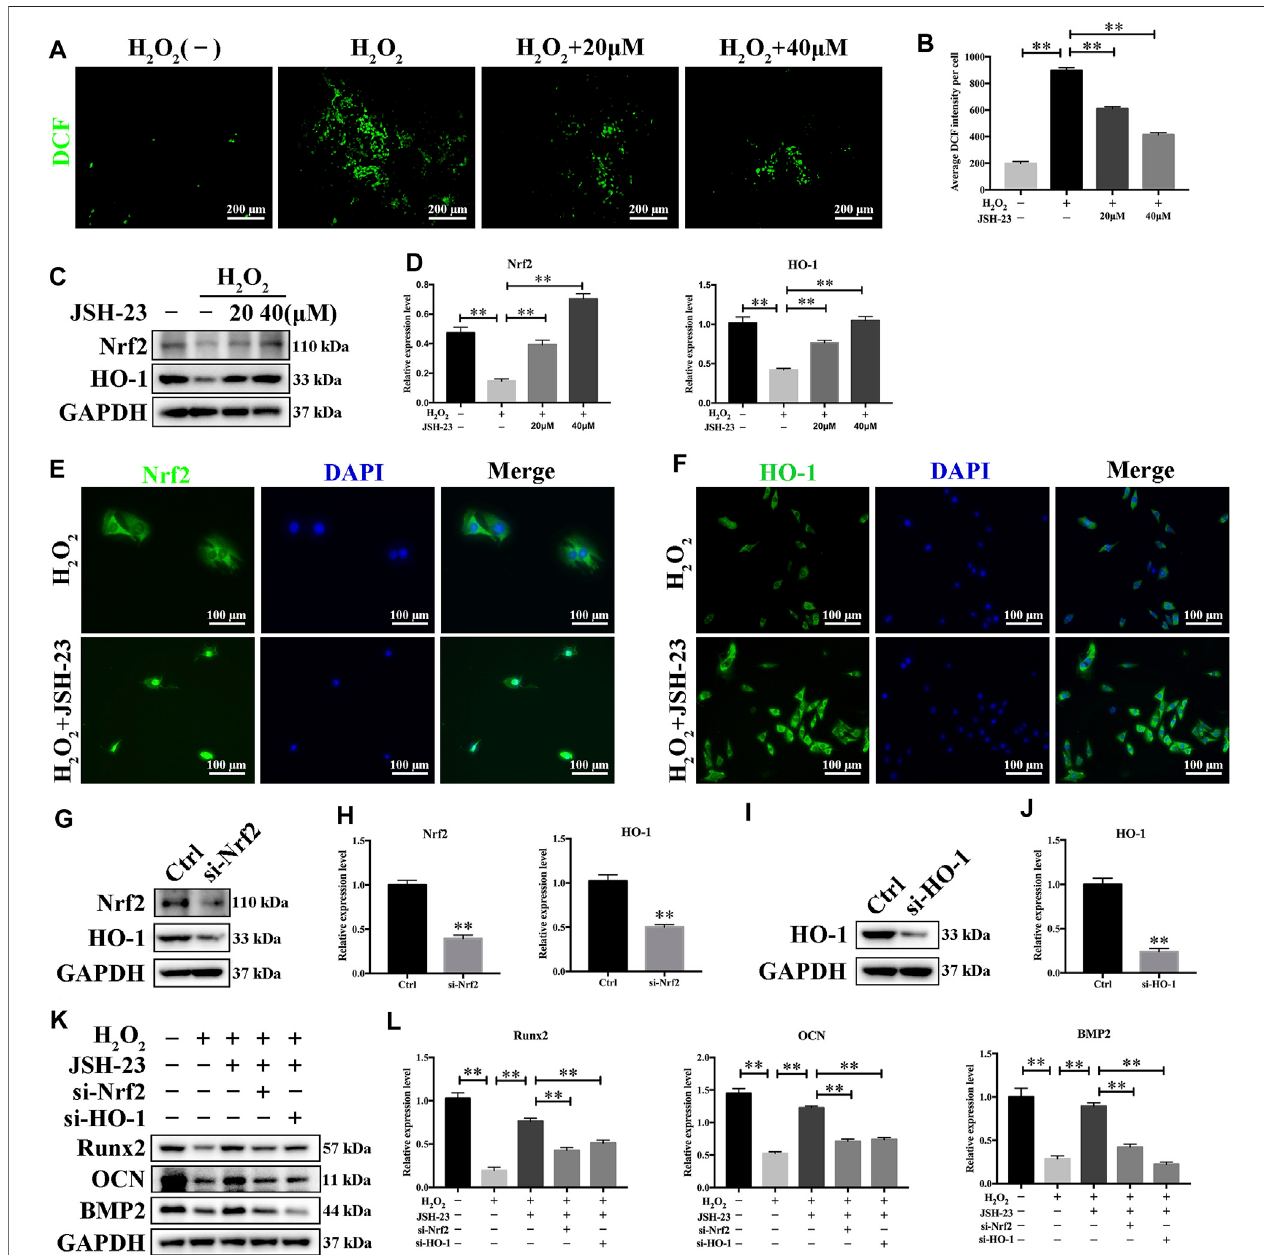
FIGURE 7 | JSH-23 scavenges intracellular ROS through increased activation of the Nrf2/HO-1 pathway in MC3T3-E1 cells. (A) MC3T3-E1 cells were pretreated with JSH-23 (20 and 40 μ M) for 24 h before stimulation with H 2 O 2 (400 μ M), and ROS generation was observed using fl uorescence microscopy. (B) The fl uorescence intensity of ROS was measured with ImageJ software. (C) Nrf2 and HO-1 expression was determined by western blotting analysis. (D) Quantitative analysis of the western blotting results. (E) MC3T3-E1 cells were pretreated with JSH-23 (20 and 40 μ M) for 24 h before stimulation with H 2 O 2 (400 μ M). The representative immuno fl uorescence imagesshow Nrf2translocation and (F) HO-1expression. (G – H) MC3T3-E1cells weretransfected withsiRNAagainst Nrf2or (I, J) HO-1 for48 h. The transfection ef fi ciency was con fi rmed by western blotting. (K) The protective effects of JSH-23 on the expression of the bone markers (Runx2, OCN and BMP2) in H 2 O 2 -treatedMC3T3-E1cellsweregreatlyweakenedbyNrf2orHO-1 knockdown. (L) Quantitativeanalysisofthewesternblottingresults. Thevaluesareshown asthe means ± SDs, n (cid:1) 3; ** p < 0.01.